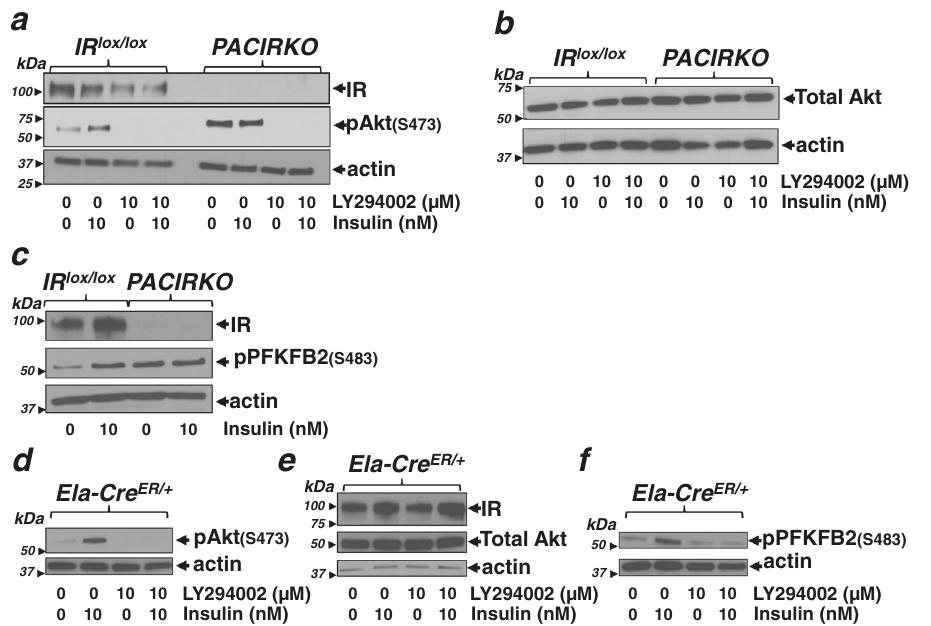
Fig. 8 Insulin increases Akt phosphorylation and the downstream Akt-mediated phosphorylation of the key glycolytic enzyme, PFKFB2, which is abolished in acinar cells from PACIRKO mice. Pancreatic acinar cells from IR lox/lox ( a – c ), PACIRKO ( a – c ) or Elast-Cre ( d – f ) were treated with or without 10 nM insulin and/or the PI3K inhibitor, LY294002 (10 μ M) for 10 min followed by cell lysis. Proteins were separated by SDS-PAGE and western blotted using antibodies for the insulin receptor (IR, a , c and e ), phospho-Akt (Ser473) ( a , d ), total Akt ( b , e ) and phospho-PFKFB2 (Ser483) ( c and f ), which recognizes the speci fi c Akt consensus phosphorylation site. For each representative experiment shown ( a – f ) separate gels were run and each membrane cut and incubated with each corresponding antibody either in parallel or in series, including IR, Akt, pAkt(S473), pFKFB2 and the loading control actin. These were all suf fi ciently separated so that they could be resolved on the same gel. Each experiment shown ( a – f ) is representative of at least three independent